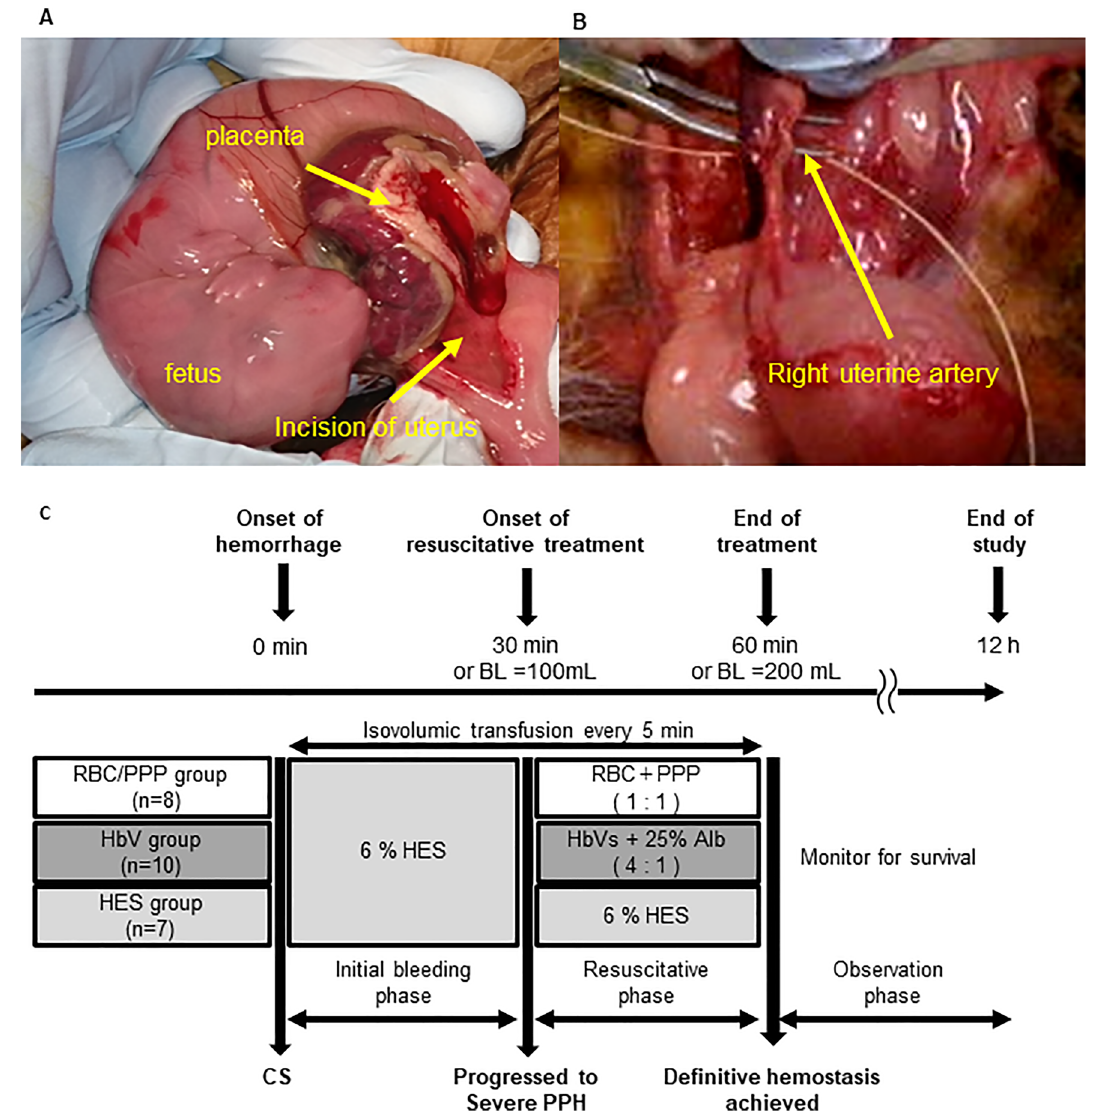
Figure 1. Surgical procedures and experimental protocol. ( A ) Rabbits underwent cesarean section to deliver fetuses from the right side of the bicornate uterus. ( B ) After closing the incision in the uterus, uncontrolled hemorrhage is induced by transecting the right uterine artery. ( C ) Pregnant rabbits undergo CS, and uncontrolled hemorrhage is progressed to severe PPH. First, all rabbits are administered 6% HES for initial treatment. After progressed to severe PPH, the rabbits receive isovolemic fluid resuscitation with an equivalent volume of hemorrhage every 5 min. Resuscitative administration regimens include the following: RBC/PPP (vol/vol = 1:1, n = 8), 6% HES ( n = 7), or HbVs with 25% human serum albumin (vol/vol = 4:1, n = 10). After 60 min from the start of hemorrhage or when the hemorrhage volume reaches 200 mL, surgical hemostasis is performed. Survival is monitored thereafter for at least 12 h. Data shown are the mean ± standard deviation. Alb albumin, BL blood loss, CS caesarean section, HbV haemoglobin vesicles, HES hydroxyethyl starch, PPH postpartum haemorrhage, RBC/PPP red blood cells with platelet-poor